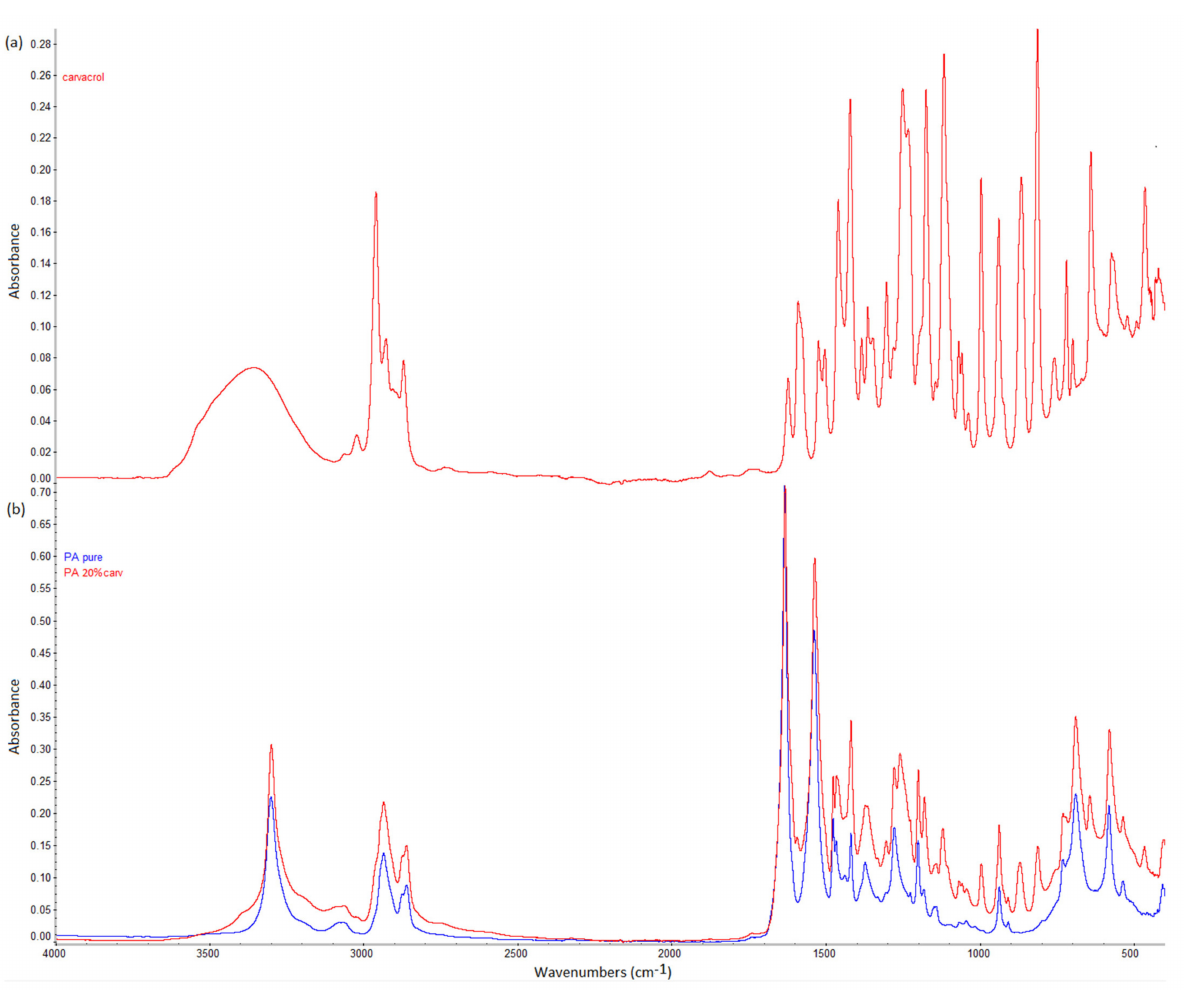
Figure 4. FTIR spectra of carvacrol ( a ) and neat and impregnated polyamide membranes ( b ). Table 1. Wavenumbers and assignments (according to data from the literature) of bands obtained by FTIR analysis for carvacrol (C), pure polyamide (PA), and carvacrol-impregnated polyamide (PA + C). Assignment C PA PA + C